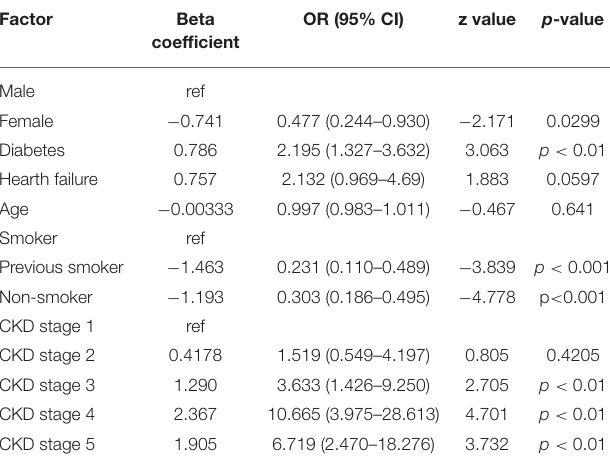
TABLE 3 | Results from binary logistic